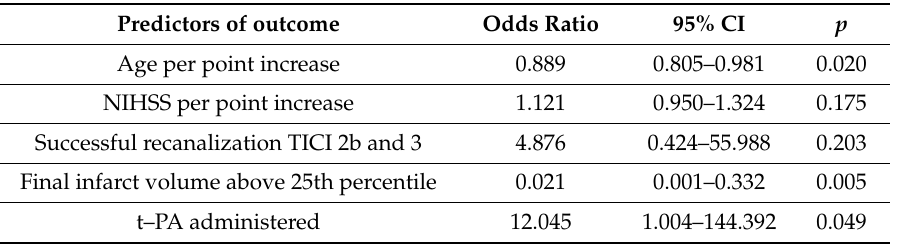
Table 3. Predictors of a good outcome after 3 months in 50 patients treated with mechanical thrombectomy due to internal carotid and middle cerebral artery